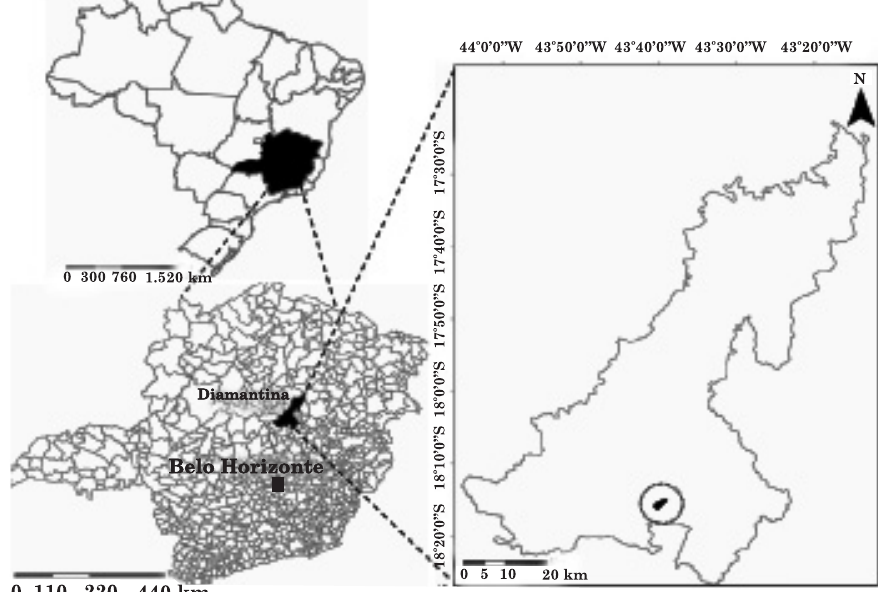
Figure 1. Location of the peatland from Pau-de-Fruta